Question: Draft a figure caption describing what is shown.
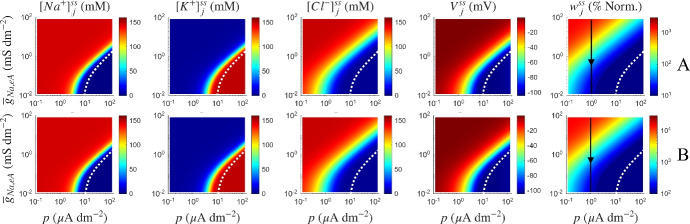
Answer: Steady-state values of compartment A (top) and B (bottom) as functions of \documentclass[12pt]{minimal} \usepackage{amsmath} \usepackage{wasysym} \usepackage{amsfonts} \usepackage{amssymb} \usepackage{amsbsy} \usepackage{mathrsfs} \usepackage{upgreek} \setlength{\oddsidemargin}{-69pt} \begin{document}$$p$$\end{document} p , \documentclass[12pt]{minimal} \usepackage{amsmath} \usepackage{wasysym} \usepackage{amsfonts} \usepackage{amssymb} \usepackage{amsbsy} \usepackage{mathrsfs} \usepackage{upgreek} \setlength{\oddsidemargin}{-69pt} \begin{document}$$\overline{g}_{Na,eA}$$\end{document} g ¯ N a , e A , shown as heat maps. The black vertical line indicates that when \documentclass[12pt]{minimal} \usepackage{amsmath} \usepackage{wasysym} \usepackage{amsfonts} \usepackage{amssymb} \usepackage{amsbsy} \usepackage{mathrsfs} \usepackage{upgreek} \setlength{\oddsidemargin}{-69pt} \begin{document}$$p$$\end{document} p is small, decreasing \documentclass[12pt]{minimal} \usepackage{amsmath} \usepackage{wasysym} \usepackage{amsfonts} \usepackage{amssymb} \usepackage{amsbsy} \usepackage{mathrsfs} \usepackage{upgreek} \setlength{\oddsidemargin}{-69pt} \begin{document}$$\overline{g}_{Na,eA}$$\end{document} g ¯ N a , e A decreases \documentclass[12pt]{minimal} \usepackage{amsmath} \usepackage{wasysym} \usepackage{amsfonts} \usepackage{amssymb} \usepackage{amsbsy} \usepackage{mathrsfs} \usepackage{upgreek} \setlength{\oddsidemargin}{-69pt} \begin{document}$$w_A^{ss}$$\end{document} w A ss and \documentclass[12pt]{minimal} \usepackage{amsmath} \usepackage{wasysym} \usepackage{amsfonts} \usepackage{amssymb} \usepackage{amsbsy} \usepackage{mathrsfs} \usepackage{upgreek} \setlength{\oddsidemargin}{-69pt} \begin{document}$$w_B^{ss}$$\end{document} w B ss . The dashed white curve traces the locus \documentclass[12pt]{minimal} \usepackage{amsmath} \usepackage{wasysym} \usepackage{amsfonts} \usepackage{amssymb} \usepackage{amsbsy} \usepackage{mathrsfs} \usepackage{upgreek} \setlength{\oddsi